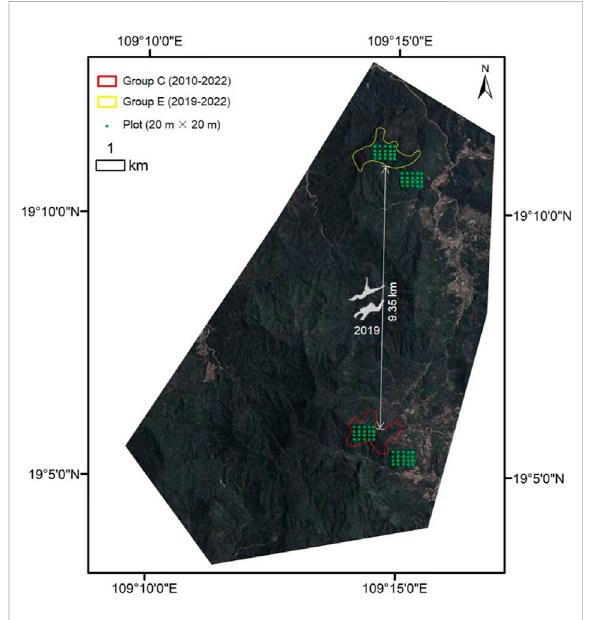
FIGURE 1 Location of our study area, the home range of group C and group E, and spatial location of all 20 m × 20 m